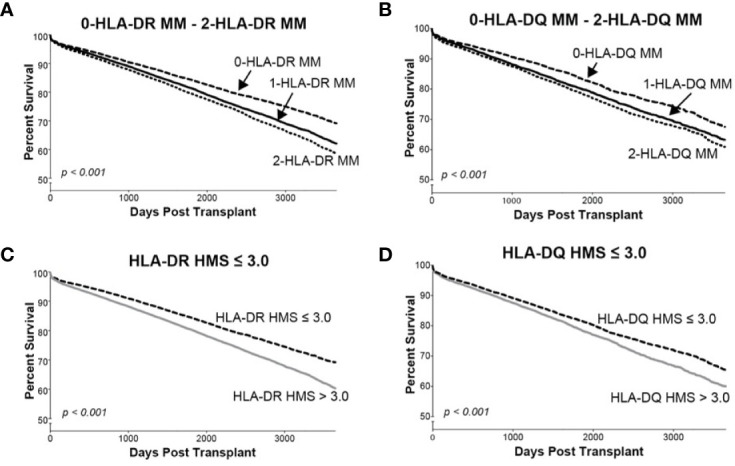
The Kaplan–Meier death-censored graft survival as a function of class II (HLA-DR and –DQ) immunogenicity in primary/re-transplant cohorts (n = 78,865). Panels (A, B) present patients stratified by mismatches at 0-, 1- or 2-HLA-DR (A) or -DQ (B) antigens. Transplants from donors with split broad antigens (for example, HLA-DR3 in donor and HLA-DR17 in recipient—this could be either a match or a mismatch) were excluded from the analysis; Panel (C) presents patients stratified by HLA-DR HMS ≤ 3.0 vs. HLA-DR HMS>3.0, and Panel (D) presents patients stratified by HLA-DQ HMS ≤ 3.0 vs. HLA-DQ HMS>3.0.